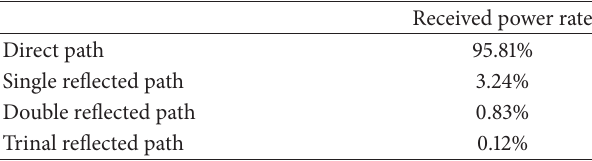
Table 1: The received power rate of each